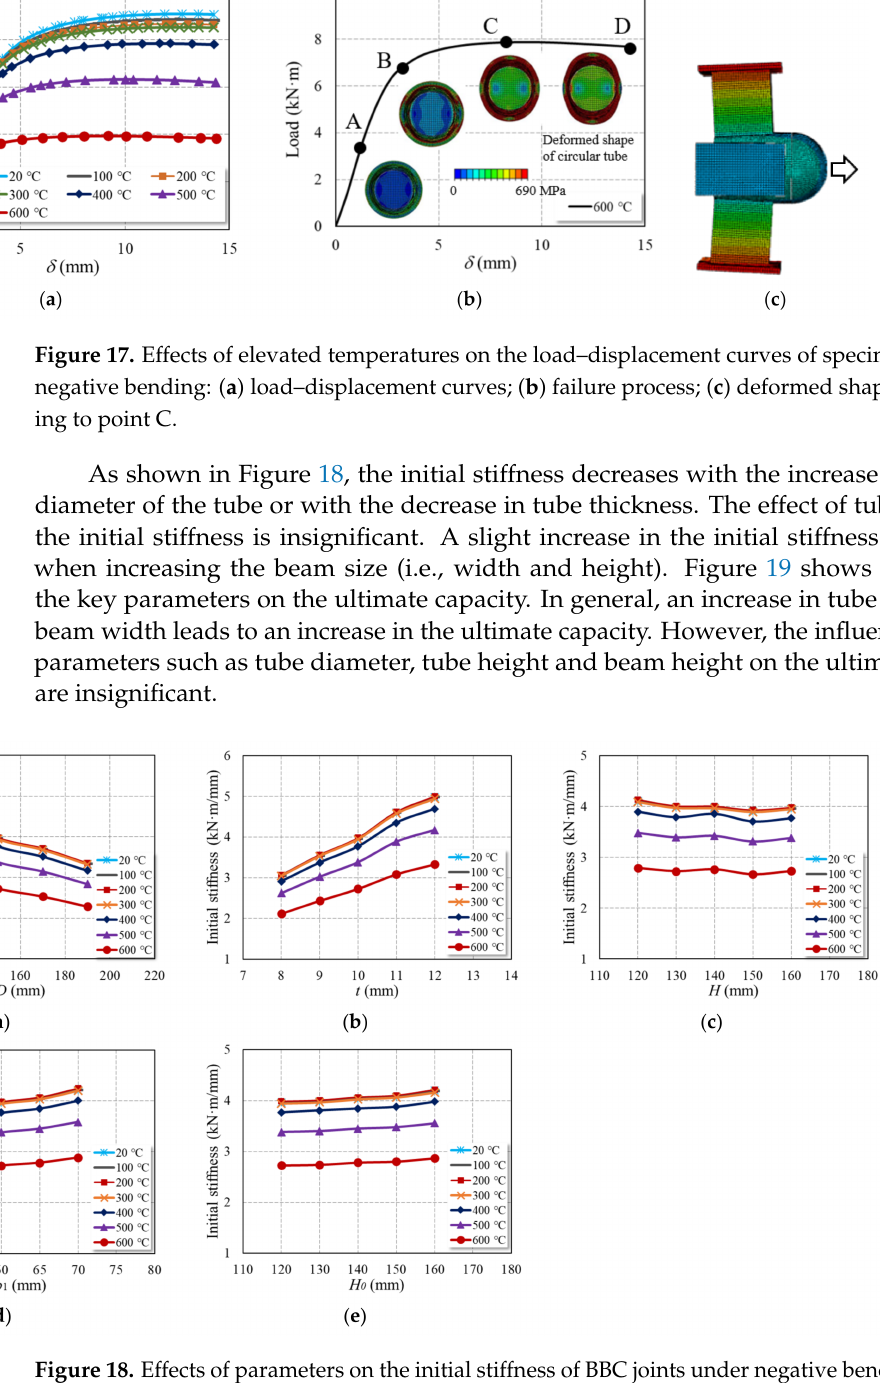
Figure 18. Effects of parameters on the initial stiffness of BBC joints under negative bending: ( a ) outer diameter of the tube; ( b ) thickness of the tube; ( c ) height of the tube; ( d ) width of the tubular beam; ( e ) height of the tubular